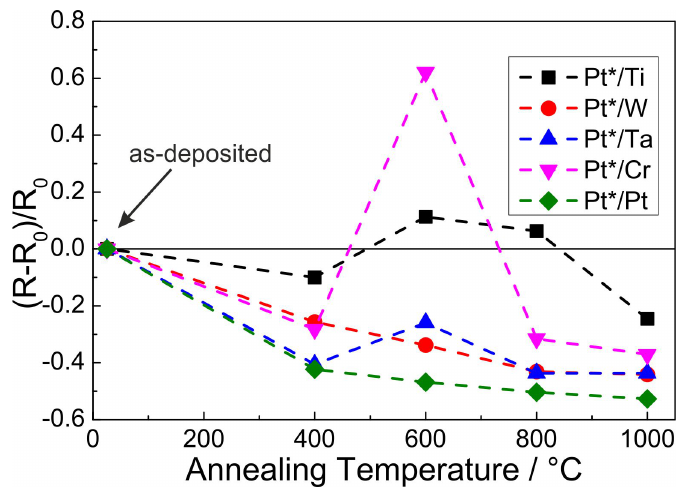
Figure 13. Relative electrical resistance of the Pt ∗ -seed bilayers with respect to the individual resistance values R 0 measured for the as-deposited samples after the annealing